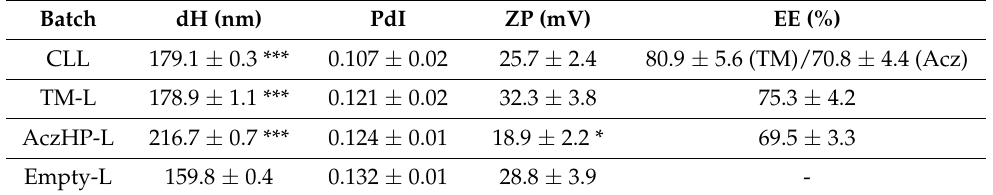
Table 6. Characterization parameters of the optimized formulation (CLL) co-loading AczHP and TM in the same vesicle and the formulations loading TM (TM-L) and AczHP (AczHP-L) separately. The groups CLL, TM-L, and AczHP-L were compared with Empty-L (*** p < 0.001; * p < 0.05).